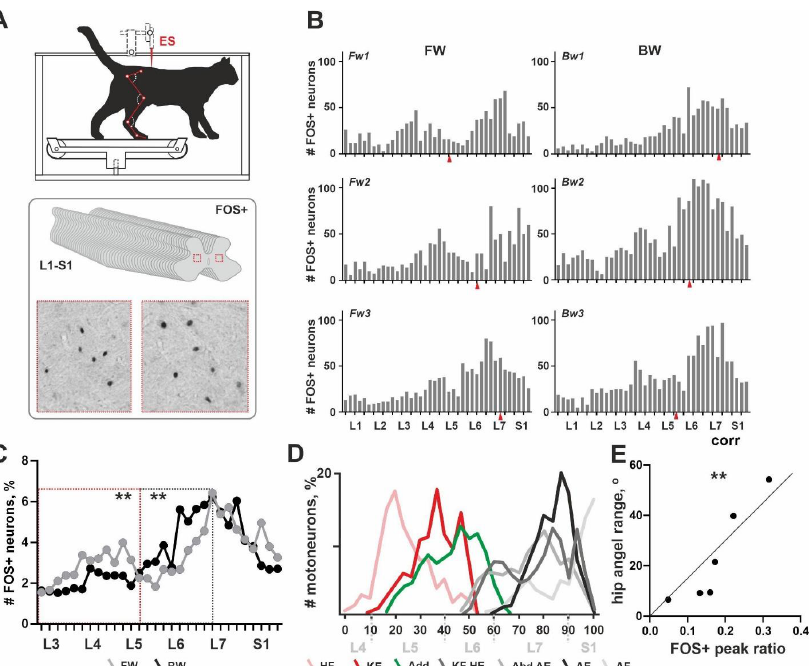
Figure 1. Rostrocaudal distribution of FOS+ neurons in cats stepping forward (FW) and backward (BW). ( A ) A scheme for the experiment. ES—epidural stimulation. Red boxes show examples of FOS+ neurons. ( B ) Individual data for individual FW (Fw1–Fw3) and BW (Bw1–Bw3) cats. OX axis, spinal segments, OY axis, absolute number of FOS+ neurons. Red arrows mark ES sites. ( C ) Difference between the averaged percent curves for the distribution of FOS+ neurons, for FW and BW cats; red and grey rectangles mark peak in the number of FOS+ neurons and inter-peak drop. ( D ) A rostrocaudal distribu- tion of the motoneuronal pools assessed from the [17] data. ( E ) Pearson correlation coefficient between the angle range of